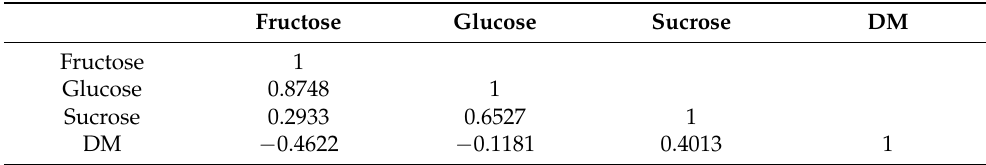
Table 2. Correlation matrix for the studied